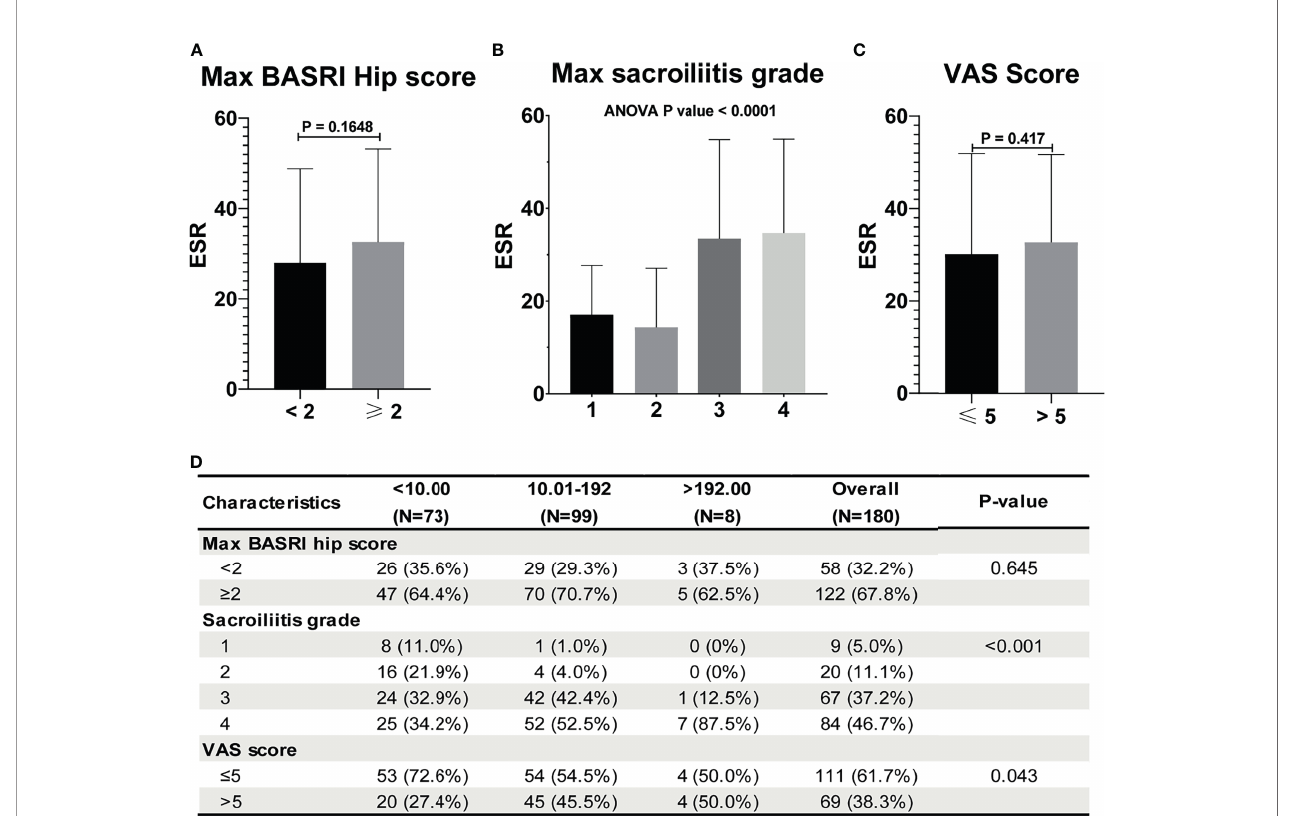
FIGURE 3 | ESR and CRP are not associated with the severity of AS. (A) ESR between AS patients with max hip BASRI socre < 2 and ≥ 2. (B) ESR in AS patients with different max sacroiliitis grade. (C) ESR between AS patients with different VAS pain score. (D) Relationship between CRP and the severity of